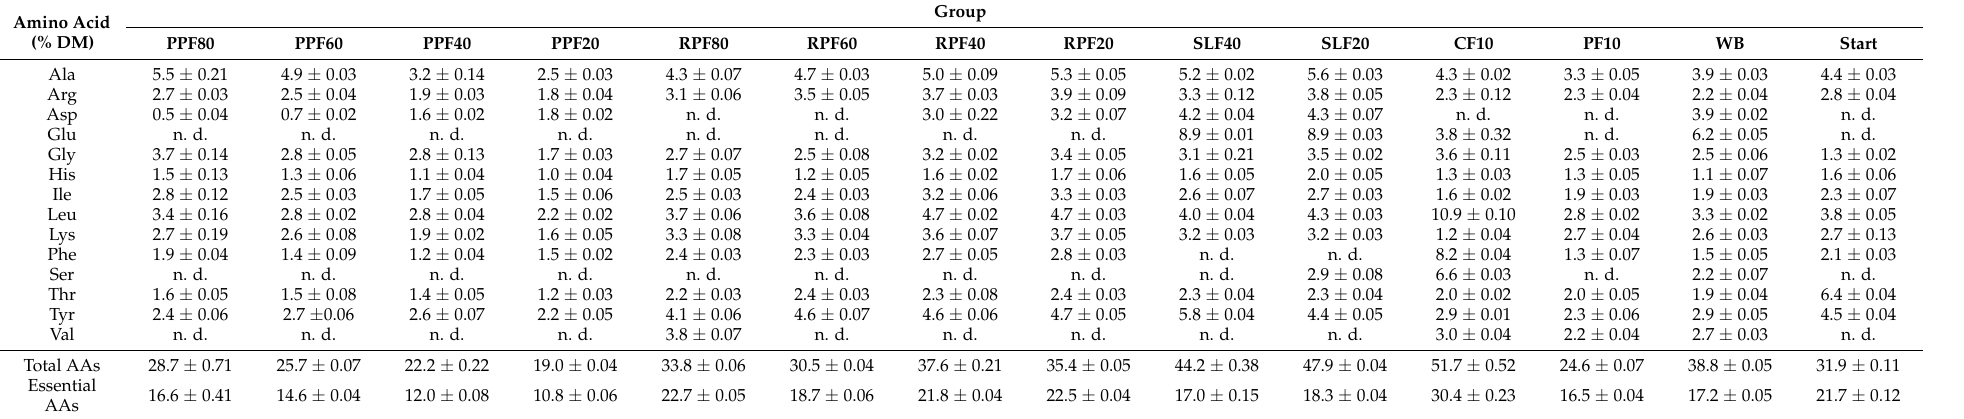
Table 8. Amino acid content of Tenebrio molitor larvae of different feeding groups (g/100 g of protein). Data are presented as mean ± standard deviation, n =